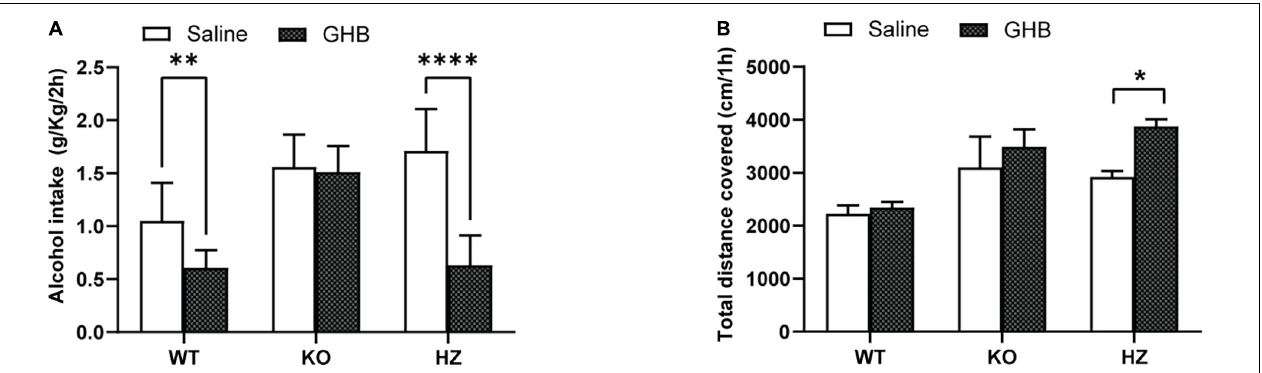
FIGURE 2 | Limited access 2-bottle choice (2BC) drinking paradigm to study the effect of GHB treatment on alcohol consumption in GABA B ( 1 ) WT, KO, and HZ mice. (A) Alcohol intake in GABA B ( 1 ) WT, KO, and HZ mice during the total period of 2BC exposition and GHB or saline treatment ( n = 5/group). (B) Spontaneous locomotor activity was recorded in GABA B ( 1 ) WT, KO, and HZ mice; total distance traveled is expressed in cm/1h (WT saline, n = 12; KO saline, n = 9; HZ saline, n = 13; WT GHB, n = 11; KO GHB, n = 10; HZ GHB, n = 14). All mice in panels (A,B) received GHB (100 mg/kg) or an equivalent volume of saline 15 min prior to the